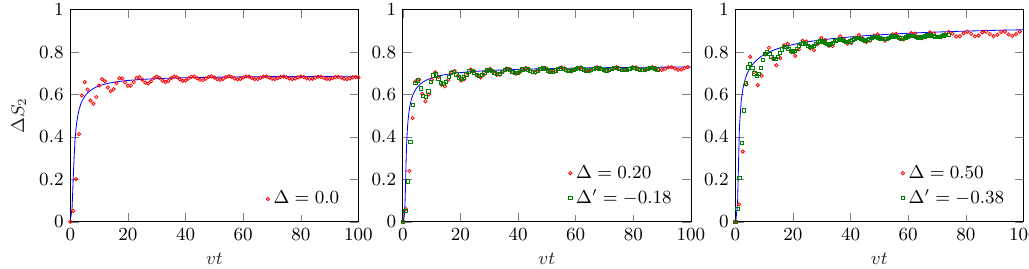
Figure 5: Growth of the Rényi entropy ∆ S for pairs of conjugate interaction param- 2 eters ∆ and ∆ (cid:48) (red and green symbols) for a chain of length L = 200. The blue solid lines show the CFT result Eq. (50) with (cid:96) = 200 and d = 1. The regularization ε = 0.55,0.40,0.35 (from left to right) was tuned to obtain the best match with the tDMRG